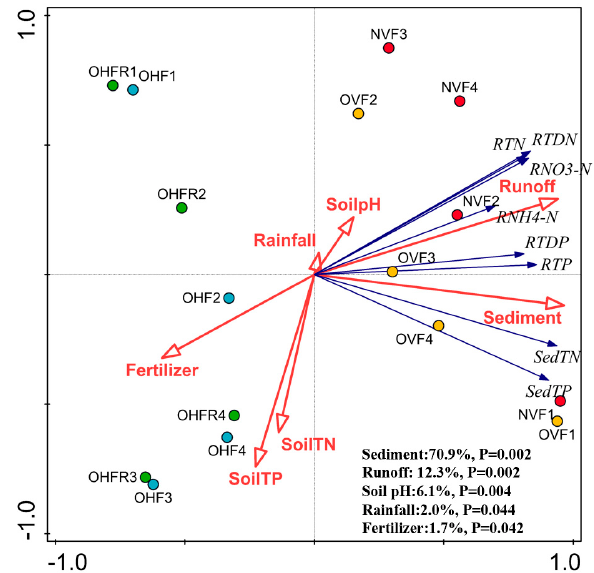
Figure 7. Linear regressions of annual TP losses and sediment yield.